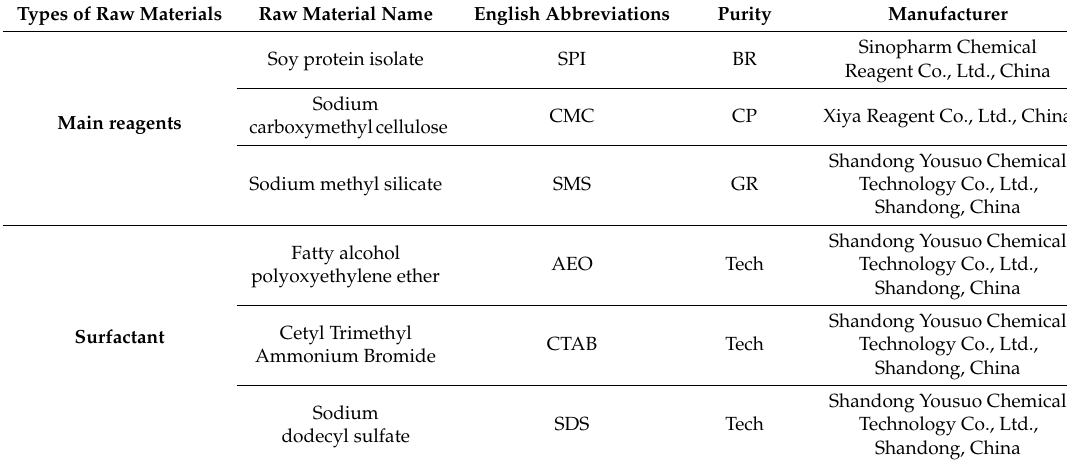
Table 1. Main experimental reagents.